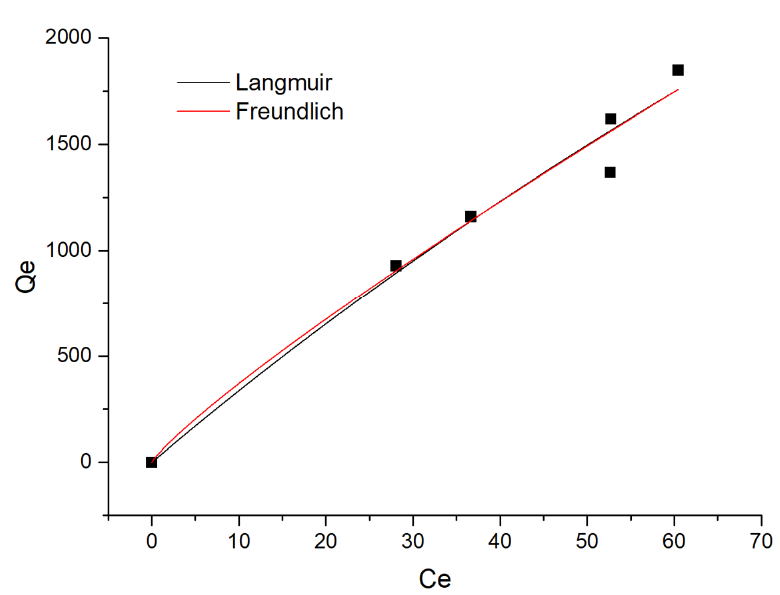
Figure 28. Thermodynamic study on the removal of carmine by rGO/Fe/Cu. Table 11. The R 2 values of the thermodynamics for carmine adsorption onto rGO/Fe/Cu nanohy- brids.